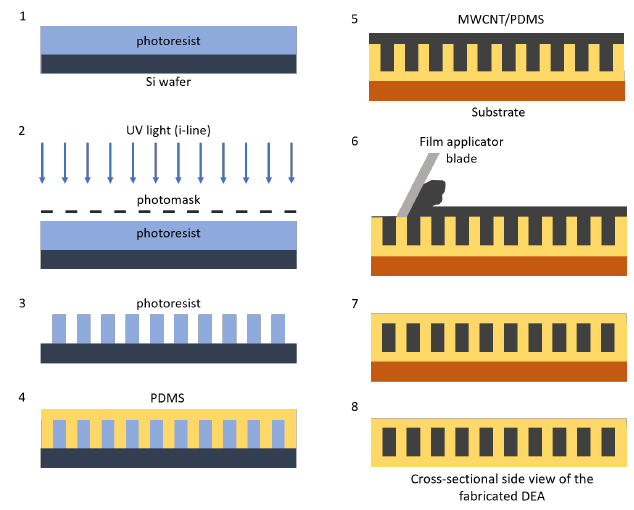
Figure 6. Schematics for the process flow for microfabrication Method I. All images show cross-sectional side views of a small section of each material/tool used during the fabrication process.